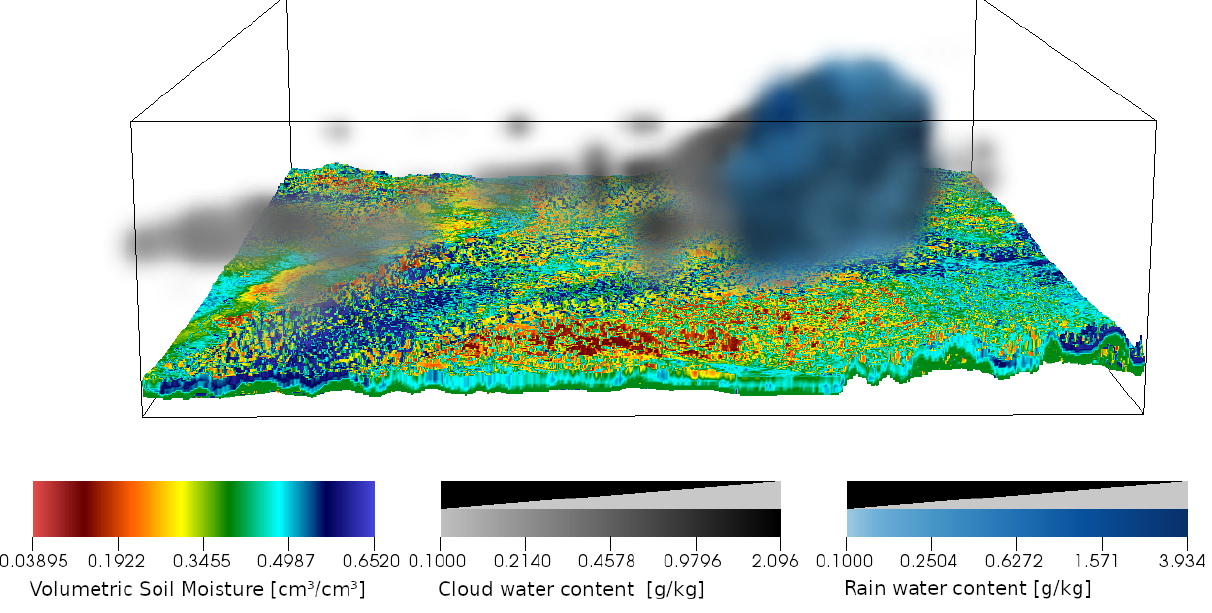
Earth Syst. Sci. Data, 13, 4437–4464,